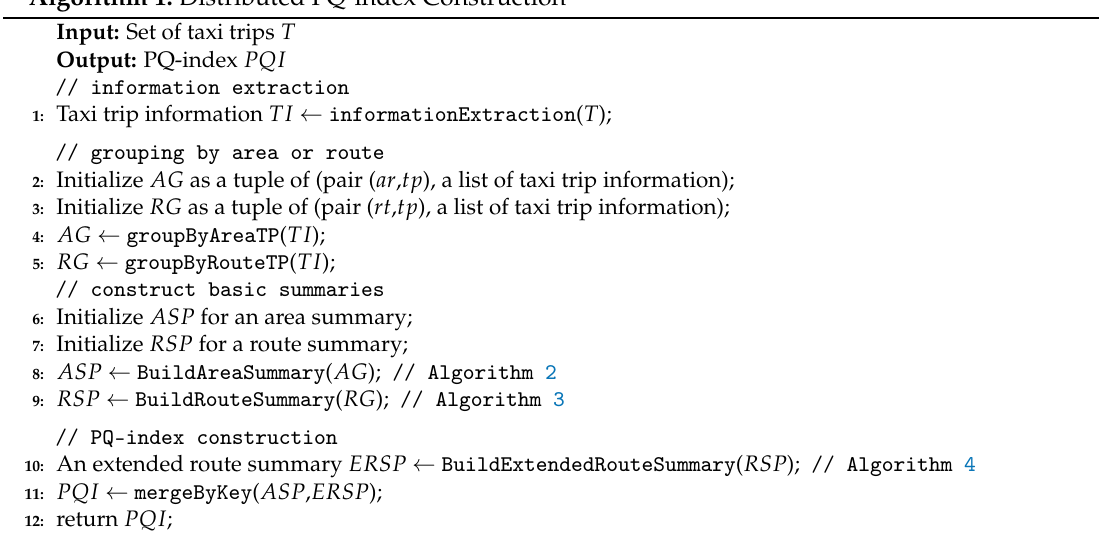
Algorithm 1: Distributed PQ-index Construction